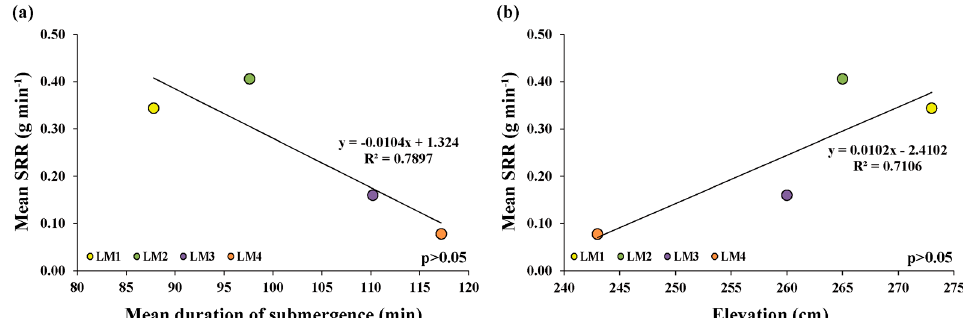
Figure 5. Correlation between ( a ) mean SRR and mean duration of submergence, and ( b ) mean SRR and elevation over the study period. Yellow, green, purple, and orange circles represent LM1, LM2, LM3, and LM4, respectively.